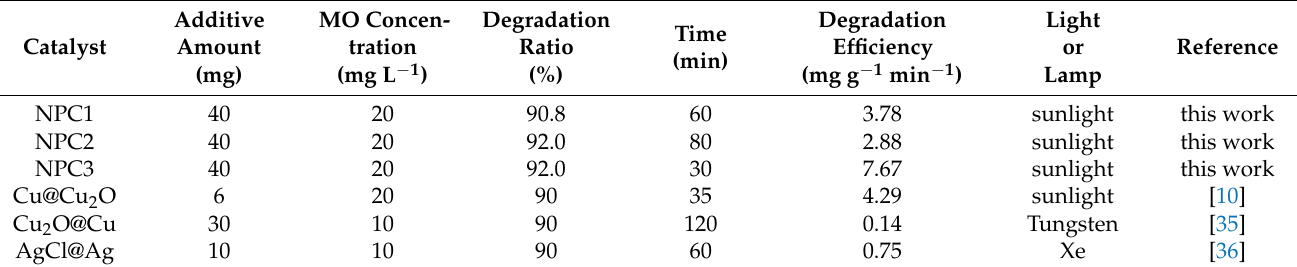
Table 2. Degradation process data of different